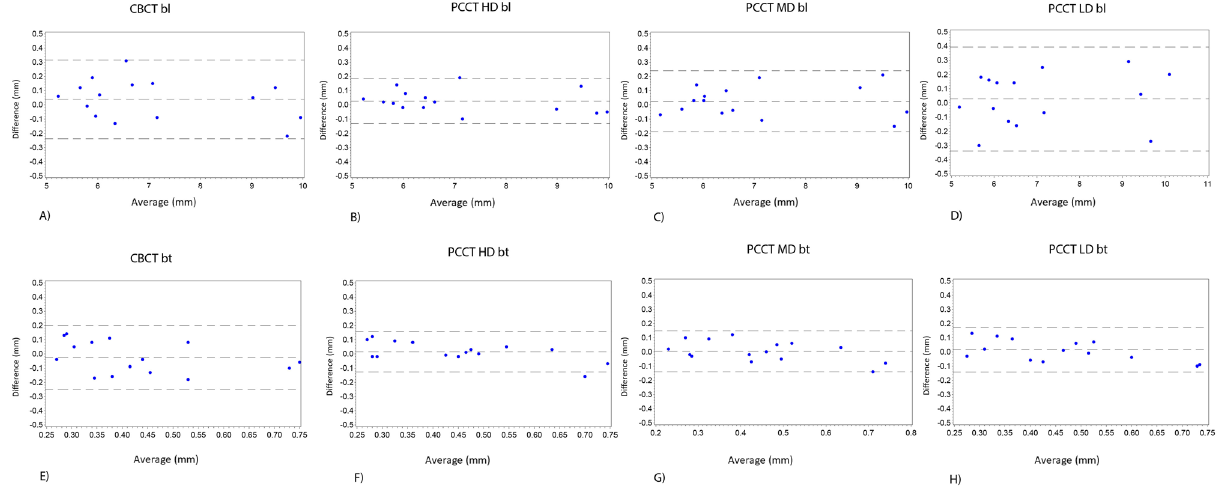
Figure 4. Bland–Altman-Plots: ( A–D ) Bland–Altman-Plots of bl -measurements of the different protocols ( E – H ) Bland–Altman-Plots of bt -measurements of the different